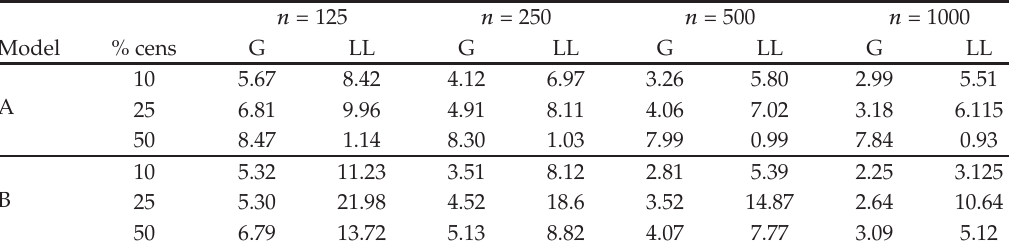
Table 2: Standard deviation (cid:3) × 10 − 2 (cid:4) of L 2 error for the density function estimators. n (cid:7) 125